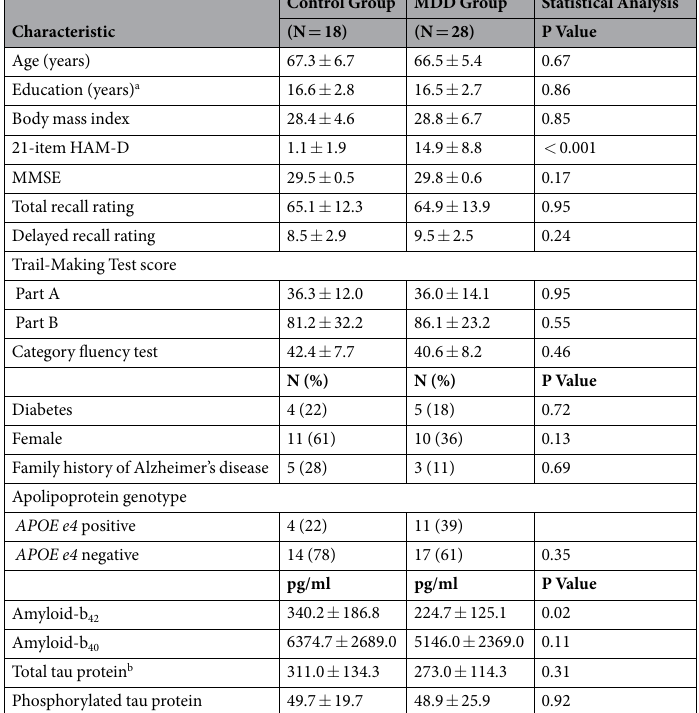
(Table 2) (Fig. 1). In addition, the analysis using covariates (BMI, sex, medication) was also statistically significant (P = 0.0037). There were no significant differences in CSF levels of other substances between the MDD and the